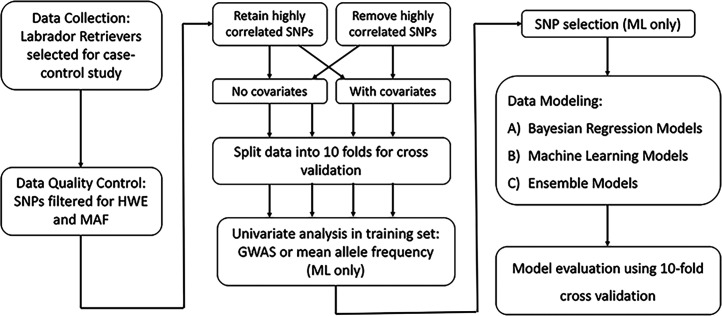
Schematic of data analysis and modeling workflow. HWE: Hardy-Weinberg equilibrium; MAF: minor allele frequency; SNP: single nucleotide polymorphism; GWAS: genome-wide association study; ML: machine learning.